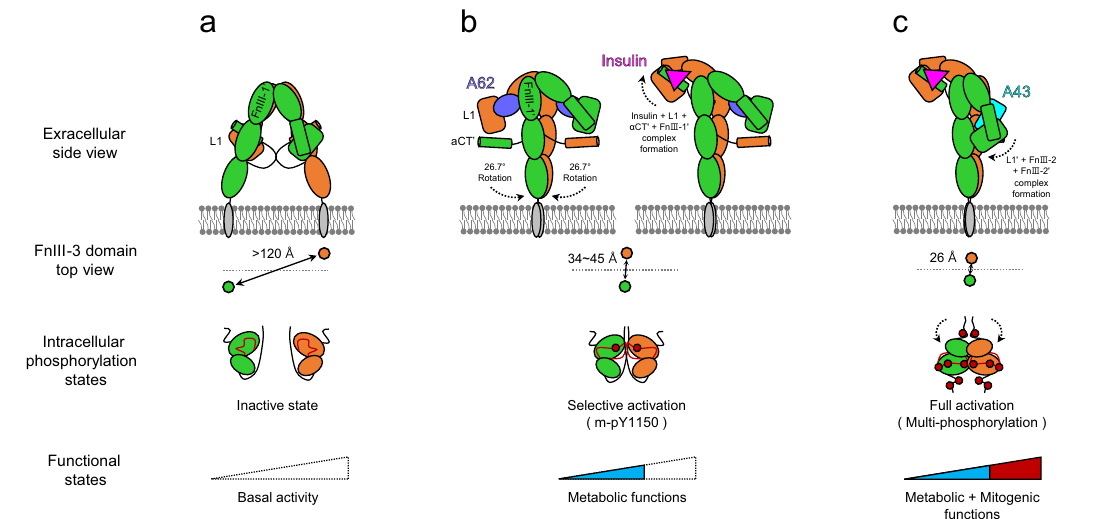
Fig. 6 | Cartoon representationofa proposed model forselective activationof IR. a Apo state with basal activity; b Two m-pY1150 states, arrowhead-shaped IR 2xA62 (left) and the tilted T-shaped IR A62+Ins (right), that selectively activate the metabolic signaling. A62 and insulin are shown in a purple circleand pink triangle, respectively. The primary insulin binding site in the arrowhead conformation can